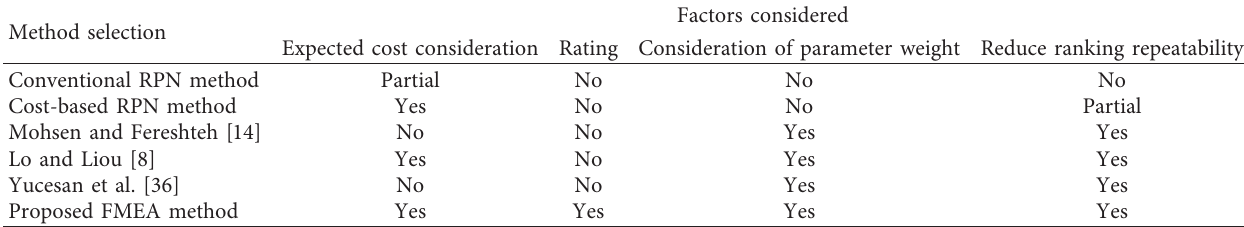
Table 7: Main differences in the three methods.